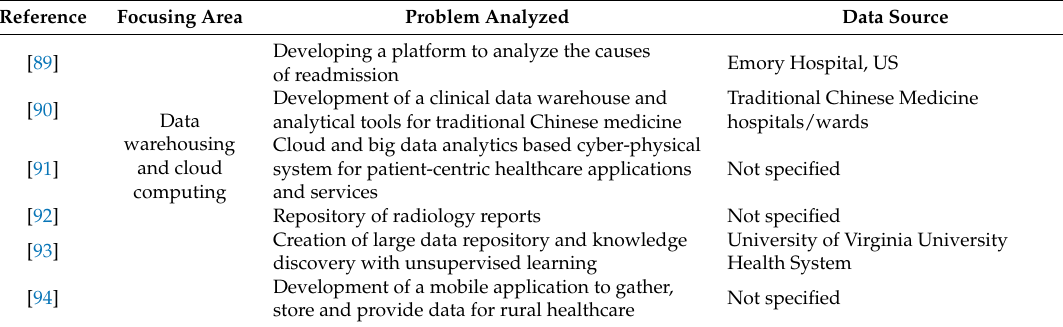
Table 6. Problem analyzed and data sources in healthcare